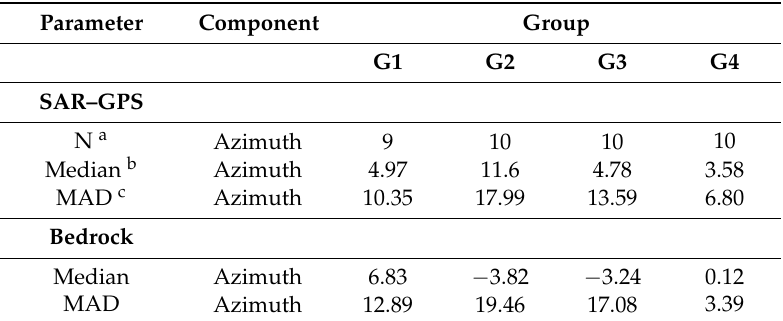
Table 6. Task 2 validation